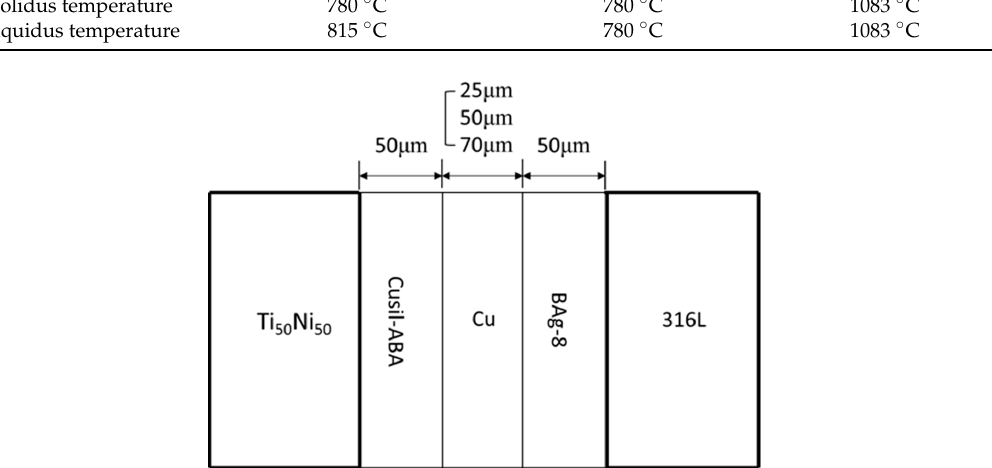
Figure 2. The schematic diagram of infrared brazing furnace.